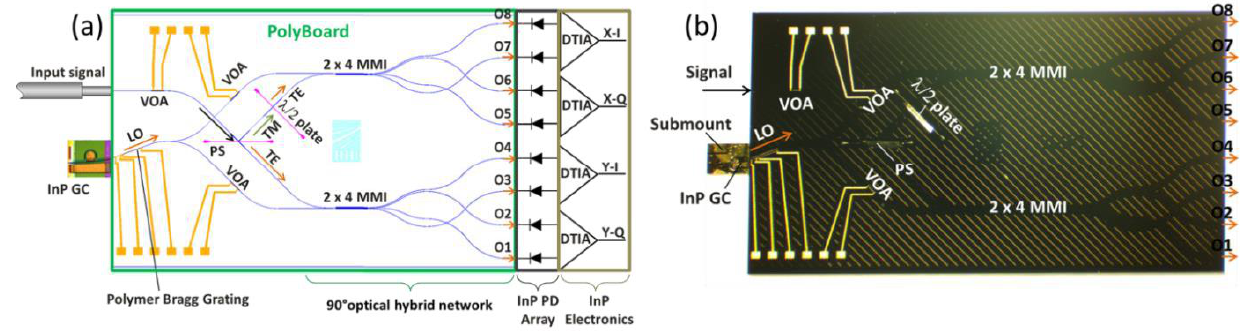
Figure 15. Optical network unit assembled on the polymer-based hybrid integration platform. ( a ) The schematic layout and ( b ) photograph of the assembly